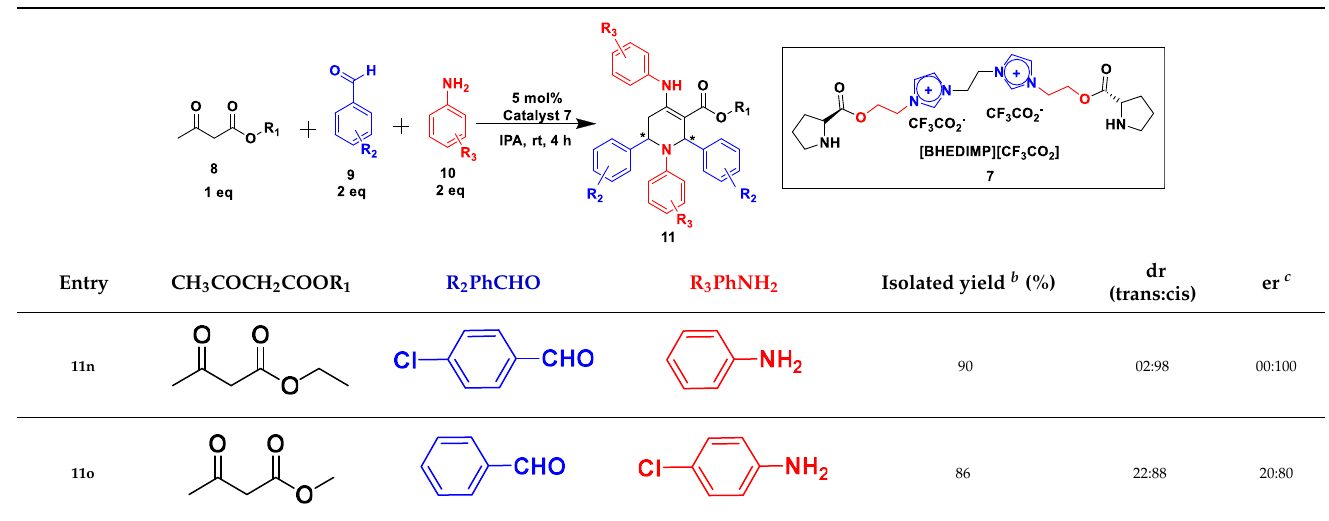
Table 3. Cont. Table 3. Substrate scope for several THP derivatives 11a – o a .